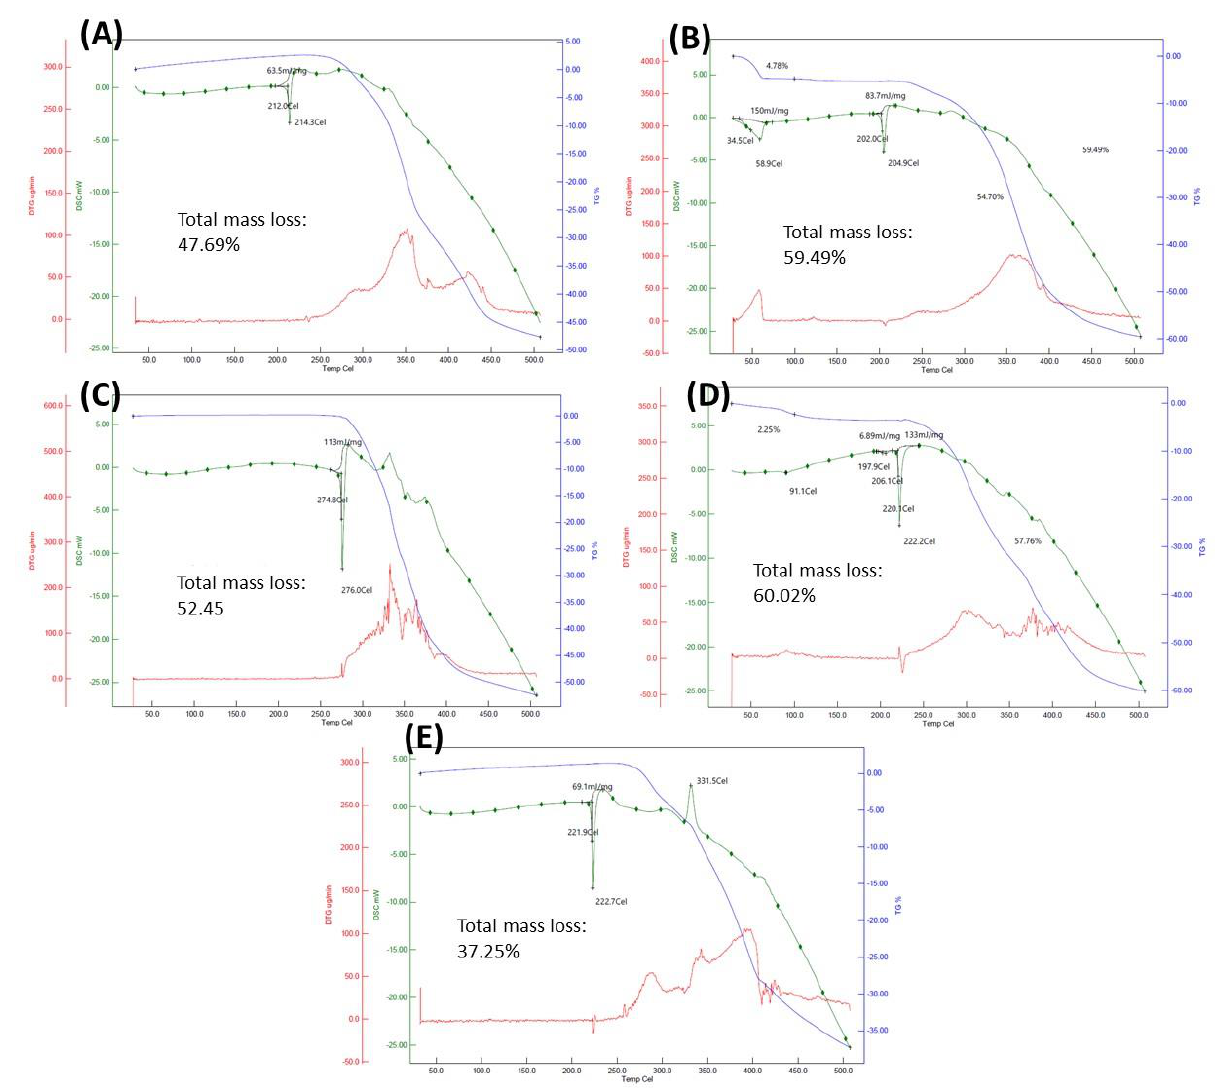
Figure 2. Thermograms obtained by STA of the API-OSs and their parent APIs: ( A ) [Clf][Of]; ( B ) [Clf][Nf]; ( C ) Of; ( D ) Nf; ( E ) Clf. Green trace—differential scanning calorimetry (DSC); blue trace—thermogravimetric analysis (TG); red trace—1st order derivative of the blue trace (DTG).